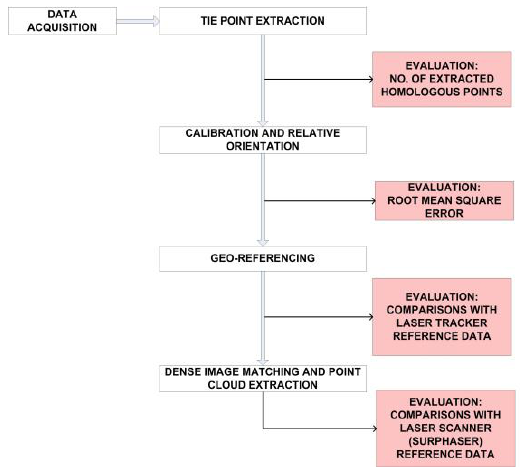
Figure 4. Procedural workflow (ISO 1